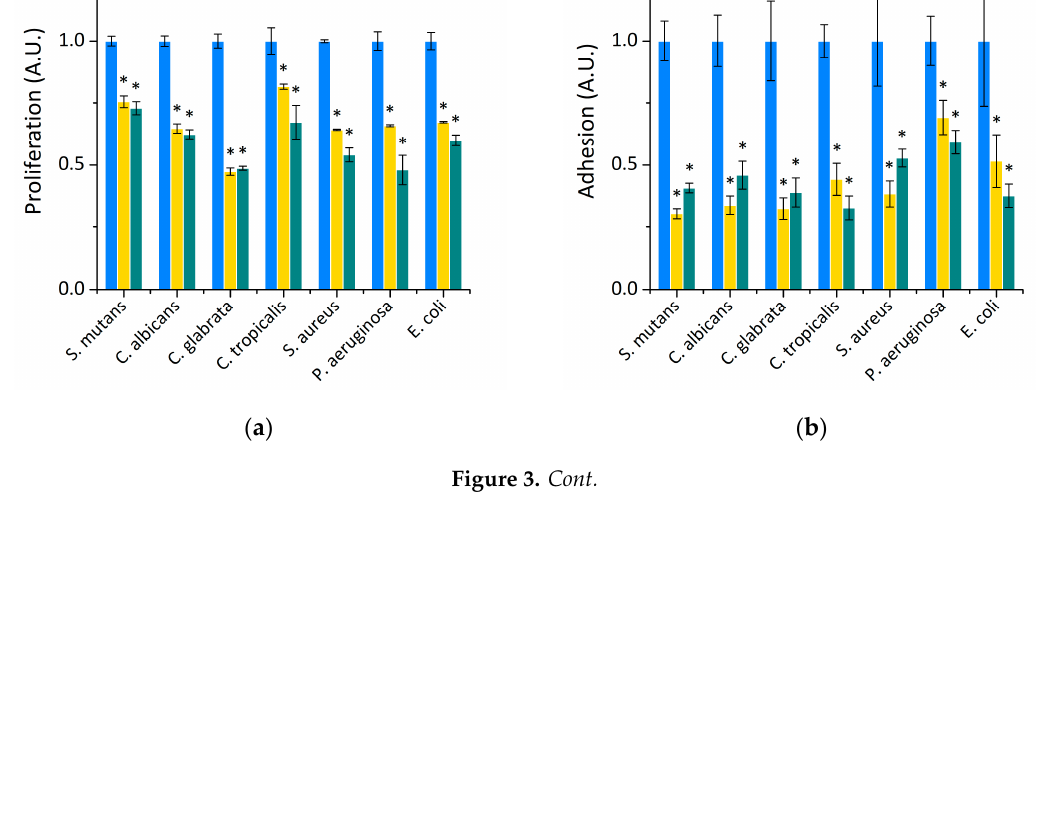
Figure 2. The mechanism of nanoparticles’ activity within the cell membrane and cytosol.